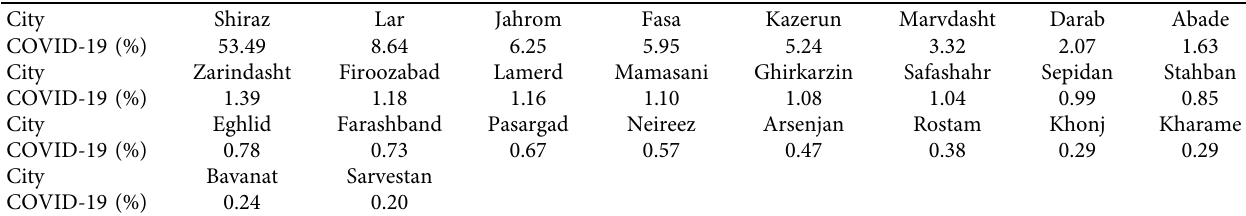
Table 1: Distribution of 53 554 COVID-19 cases in 26 cities of Fars province, Iran, February 18–September 30, 2020. City